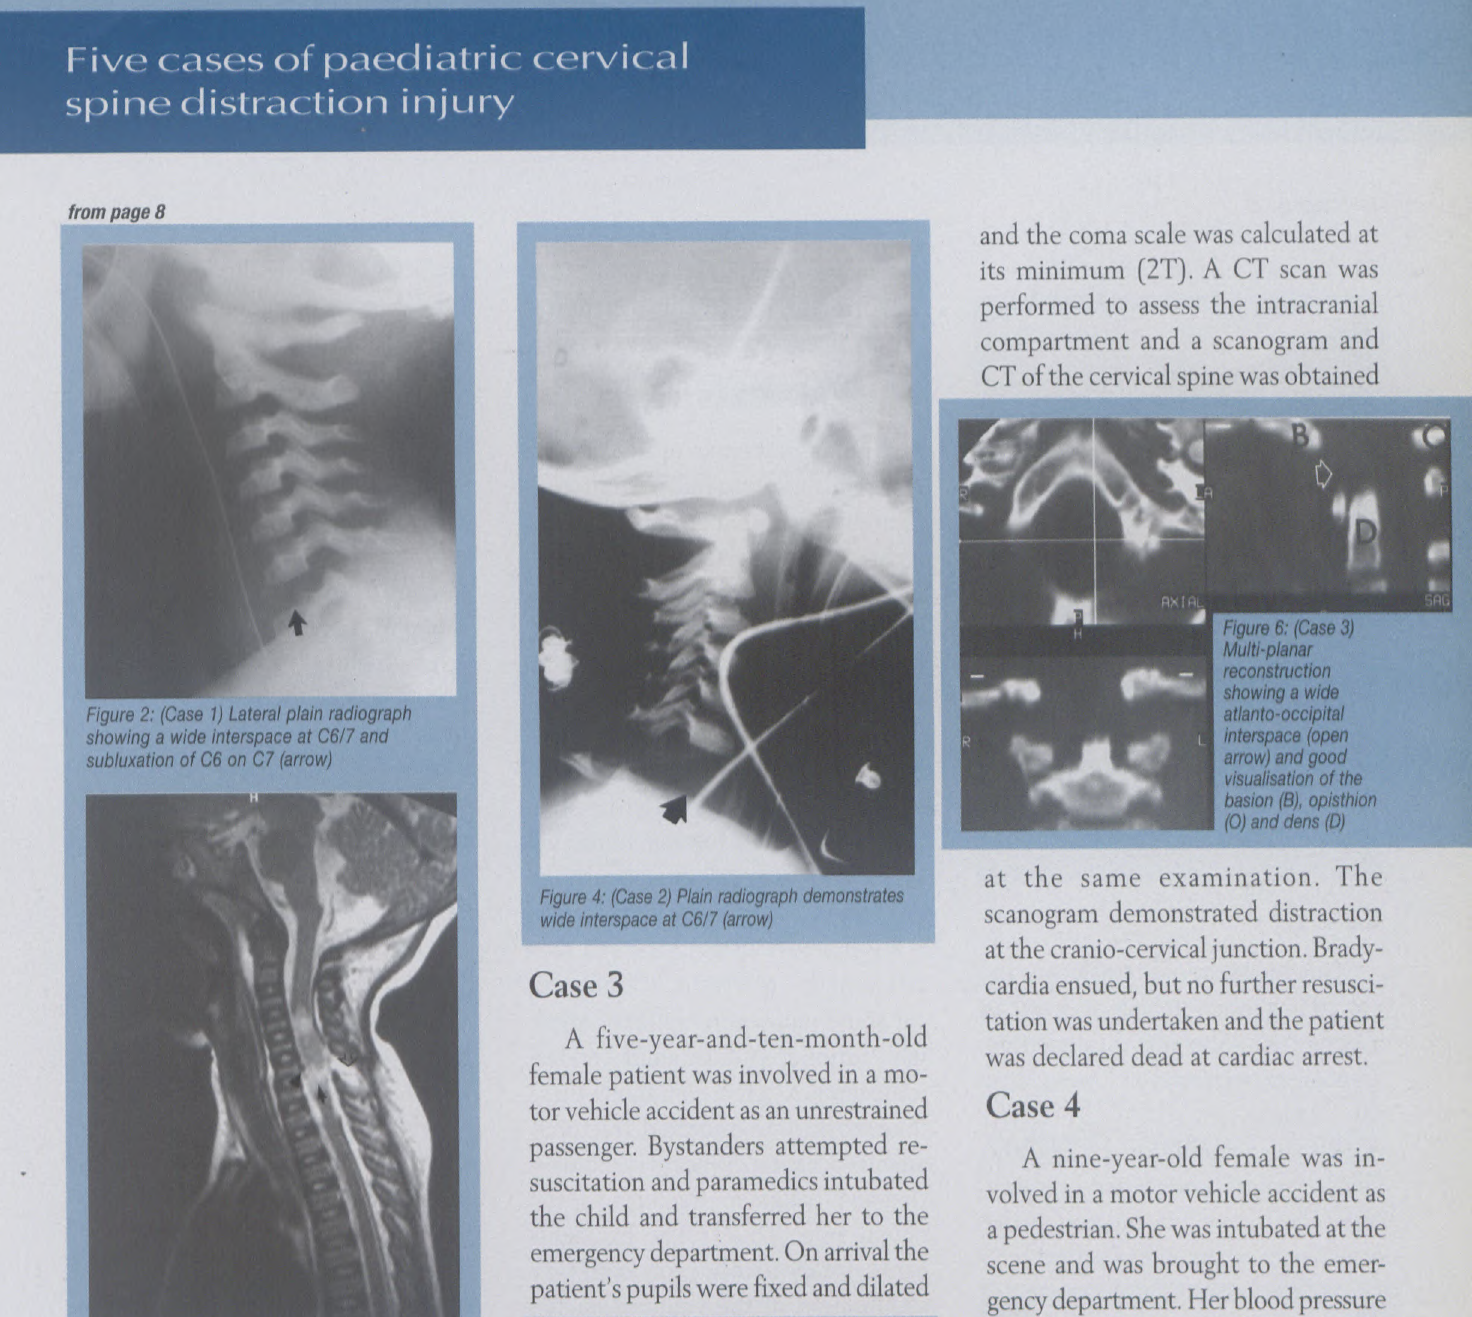
Figure 3: (Case 1) Saggital T2 weighted MRI showing complete cord transecton (closed arrow) and disruption of the posterior longitudinal (arrowhead) and interspinous ligament (open arrow)